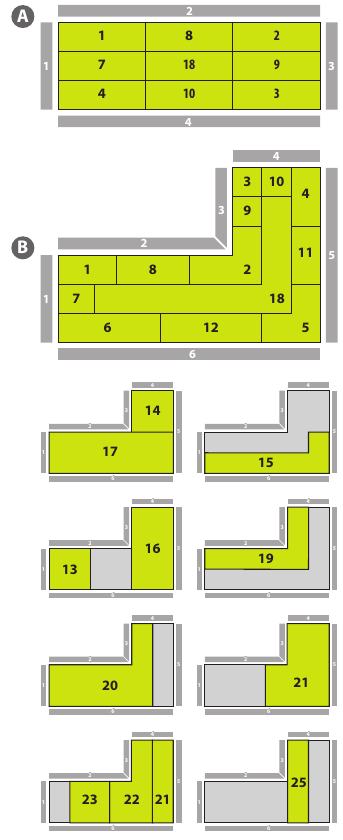
Figure 10. Possible encoded positions of a room within a floor- plan. Nine possible positions in I-shaped floorplans (A). 25 po- sitions are possible in L-shaped floorplans (B). The position en- coding is used as a feature for the